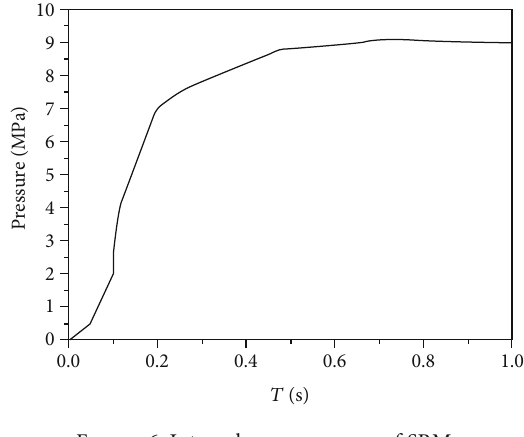
Figure 6: Internal pressure curve of SRM. Table 1: Performance parameters of the SRM.